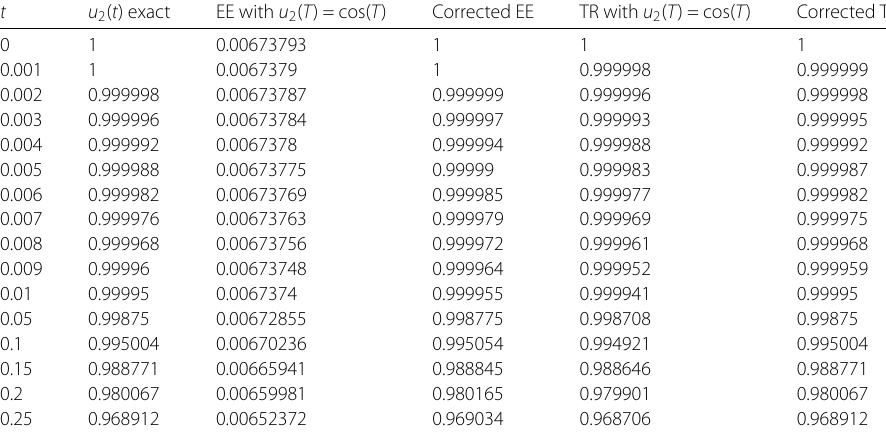
Table 5 Kneser’s differential equation: Computation of Cosinus solution for φ ( t ) =